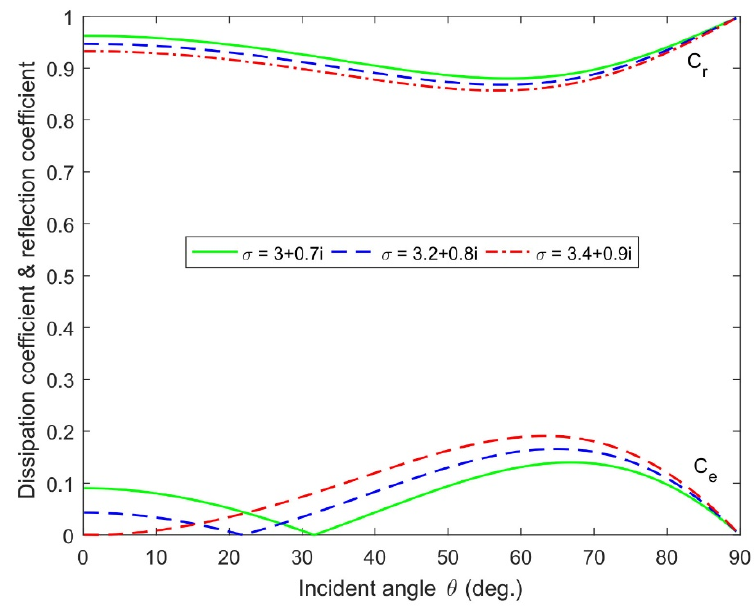
C and C versus θ with = 0.4 d h . Figure 7. Effects of σ on the C r and C e versus θ with d / h = 0.4. r e